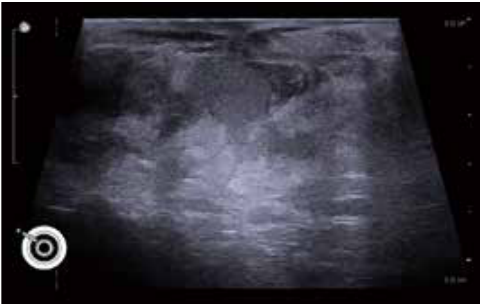
Figure 3 TRUS image of sagittal view at about 10 o’clock. The rupture of the internal sphincter was mistakenly considered as an internal opening of the abscess at first due to blurry appearance of the intersphincteric groove.